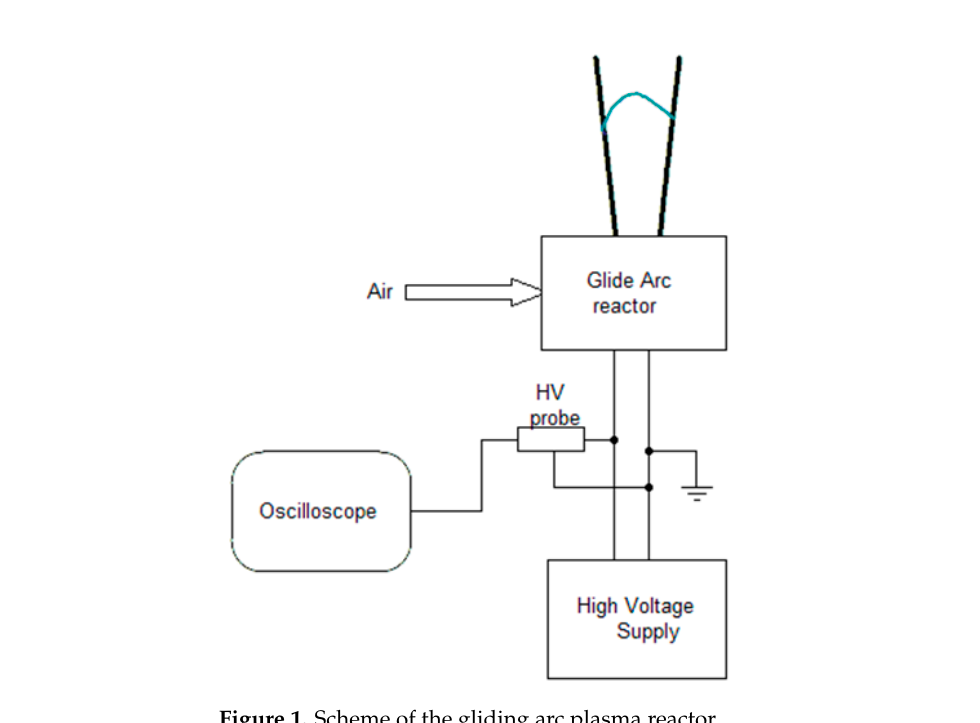
Figure 1. Scheme of the gliding arc plasma reactor.